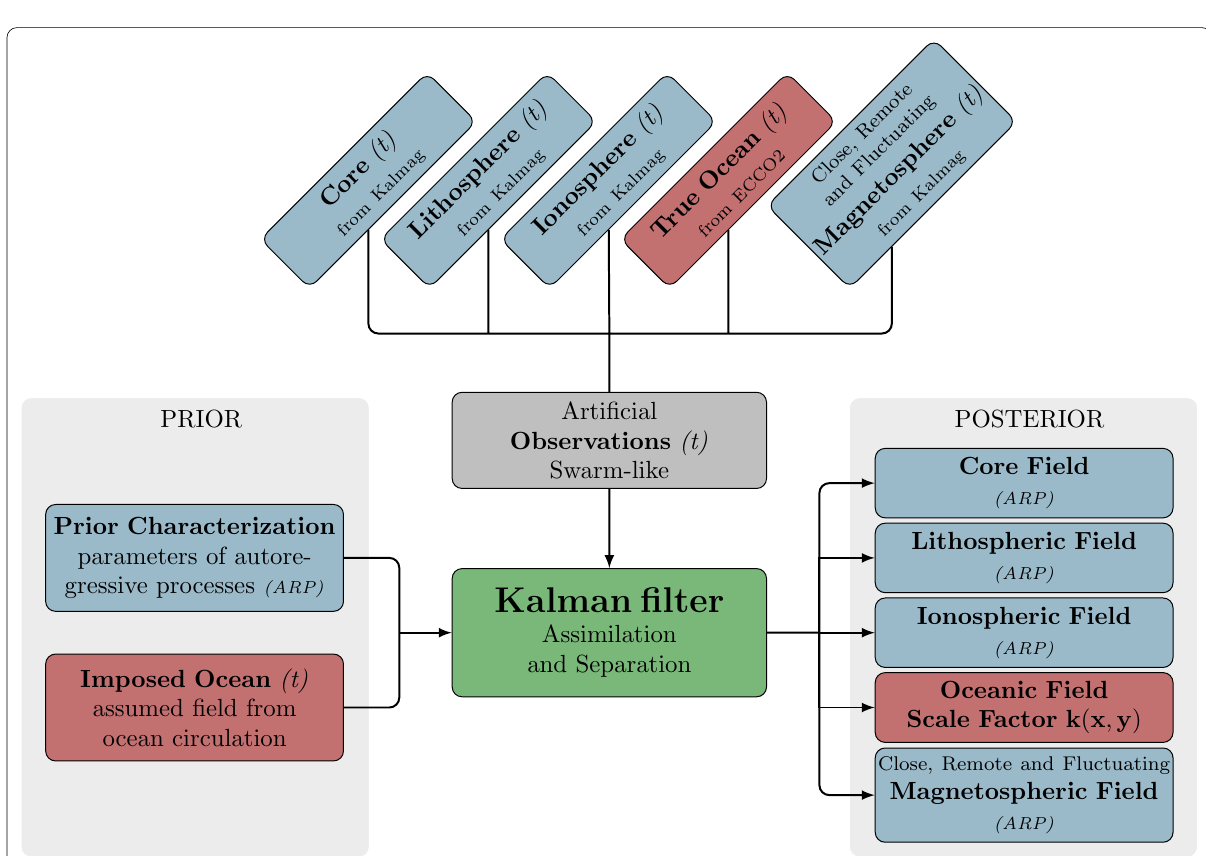
Fig. 3 Sketch of the OSSE illustrating the input of the assimilation and the separation of the different magnetic field contributions. The magnetic component from ocean circulation is highlighted in red. The other contributions modeled by autoregressive processes (ARP) are marked in